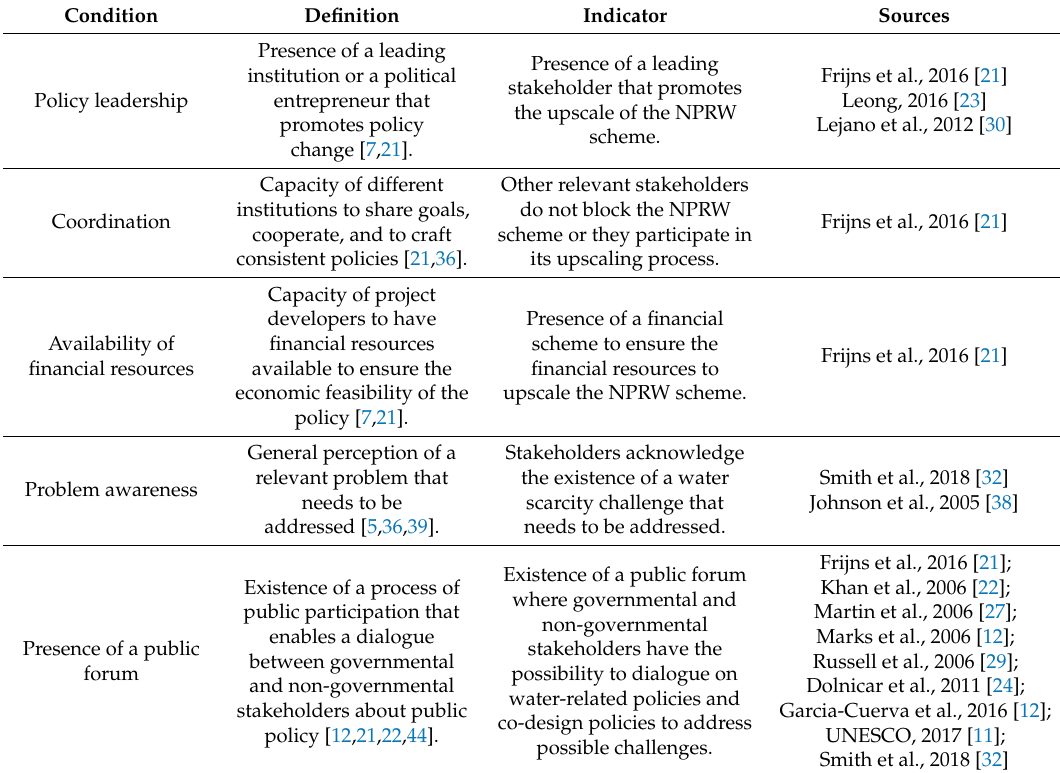
Table 1. Enabling governance conditions to ex-ante analyze the upscaling of the non-potable recycled water (NPRW)